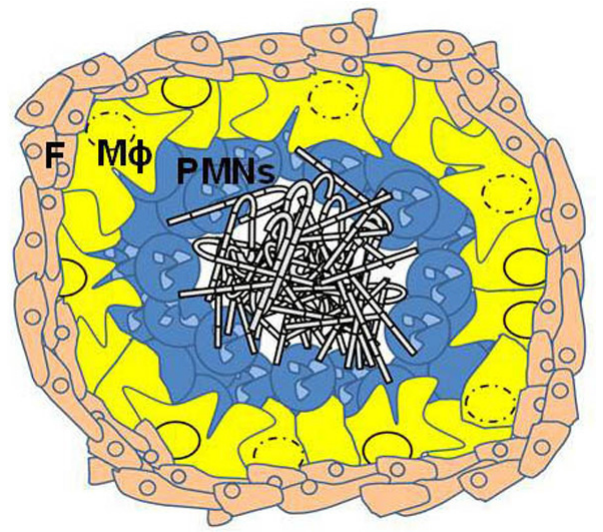
Figure 4. Scheme of peritoneal abscess observed in animals after 15 days post-infection with hyphae of F. pedrosoi. Abscess layers: fibroblasts (F, orange), macrophages (MΦ, yellow), polymorphonuclear leucocytes (PMNs, blue) and hyphae in abscess center.